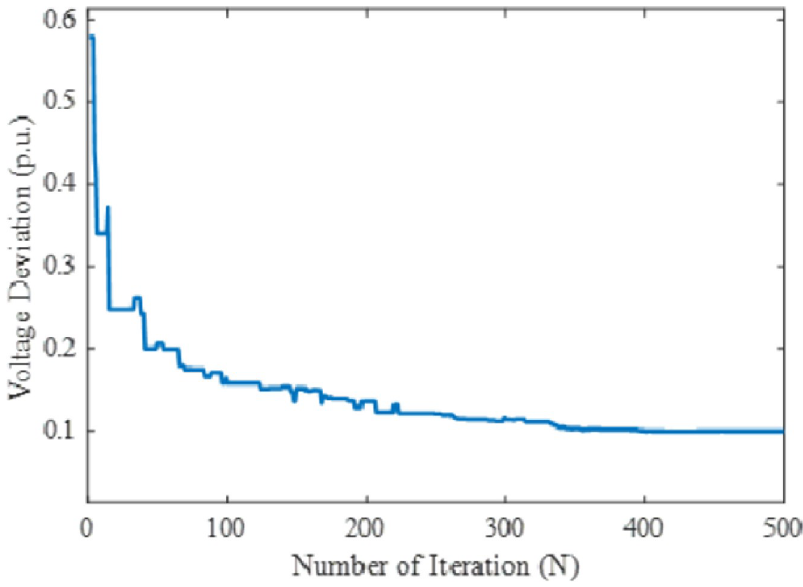
Fig 7. Convergence property of the proposed MPA for case